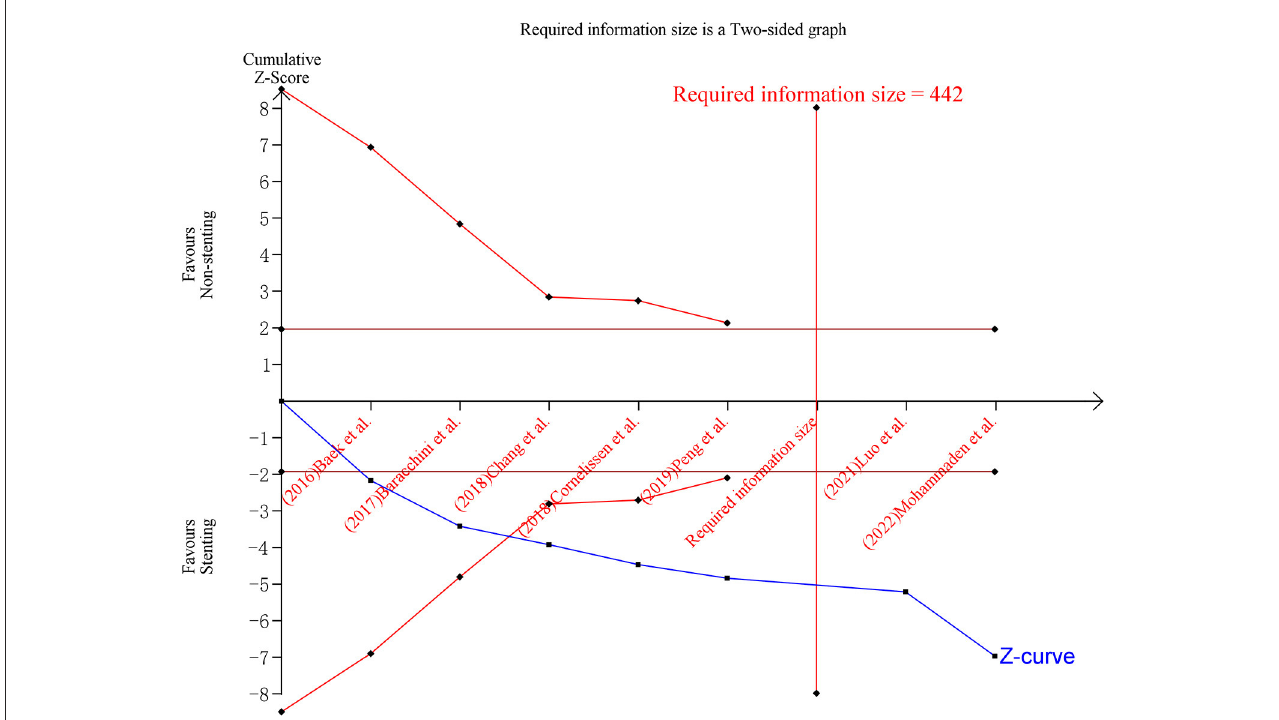
FIGURE5 TSA analysis on the mRS score. mRS score of 0–2 is a positive outcome for patients receiving rescue stenting. The x -axis ticks refer to the studies added sequentially into the analysis. The blue curve was the adjusted Z -curve, and it crossed the dark-red horizontal line (conventional boundary for α = 0.05). The vertical red line shows the required information size—the needed sample size for a robust result with sufficient statistical power. The analysis included 704 participants, which exceed the required information size ( n = 442). mRS, modified Rankin Scale; TSA, trial sequential analysis.